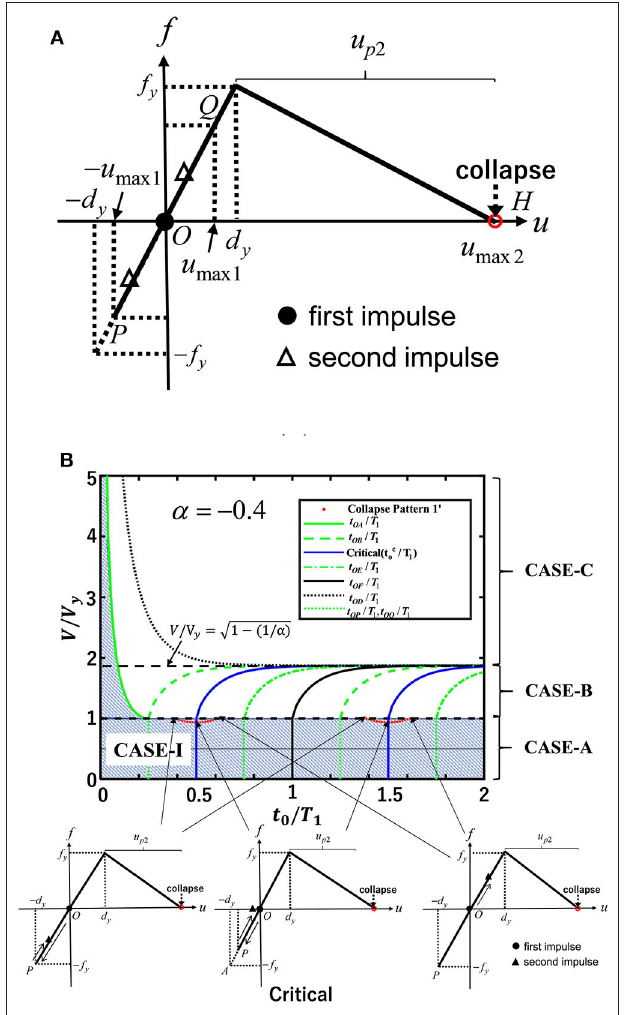
FIGURE 4 | Collapse pattern 1 ′ (CASE-A): (A) Restoring-force characteristic. (B) Second impulse timing t 0 / T 1 -input velocity relation.